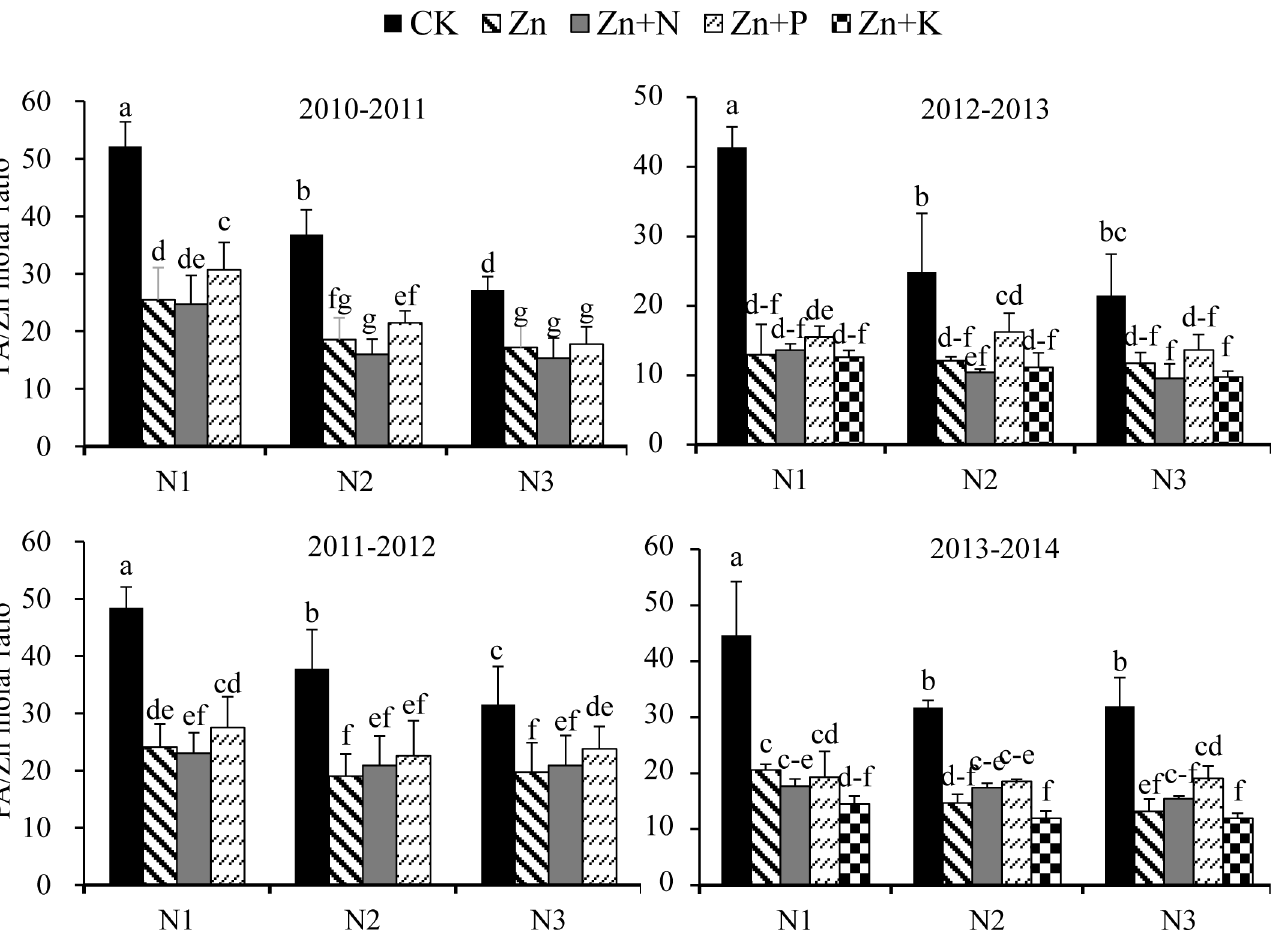
Fig 2. Grain PA/Zn molar ratio of winter wheat as influenced by soil N fertilizer rate (0 [N1], 120 [N2] or 240 [N3] kg N ha -1 ) and foliar fertilizer applications (distilled water spray [CK], ZnSO 4 (cid:1) 7H 2 O [Zn], ZnSO 4 (cid:1) 7H 2 O+urea [Zn+N], ZnSO 4 (cid:1) 7H 2 O+KH 2 PO 4 [Zn+P], and ZnSO 4 (cid:1) 7H 2 O+ K 2 SO 4 [Zn+K]) at Yangling. In 2010–2011 and 2011–2012,foliar Zn+K were not applied. Error bars represent standard error (n = 4). PA: phytic acid. Bars havingdifferent lowercaseletters are significantly different ( P <